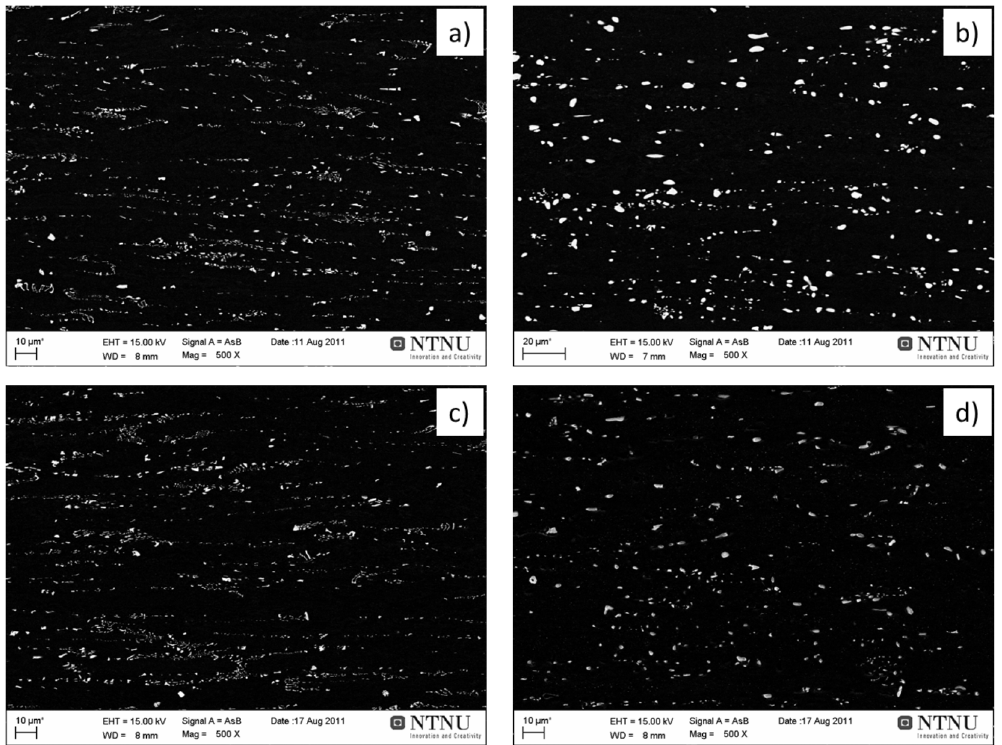
Figure 4. Back scatter electron SEM images of constituent particles after cold rolling strain of ε = 1.6: ( a ) C2-0; ( b ) C2-1; ( c ) C2-2; and ( d ) C2-3. RD-ND (vertical) section.